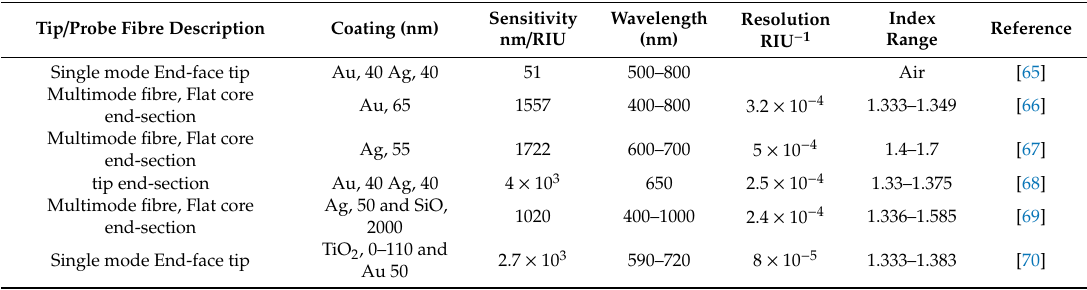
Table 3. Summary of various fibre end-face plasmonic